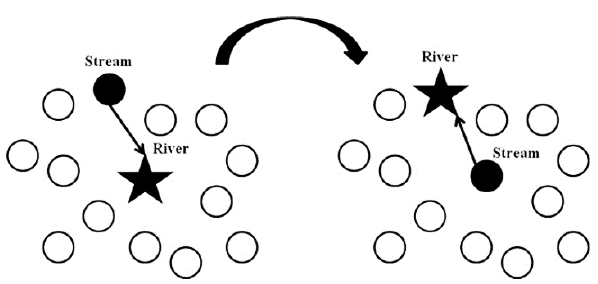
Figure 4. The position of the stream (raindrop) and the river replacement [38]. The star is the river and the black circle is the best among other streams.